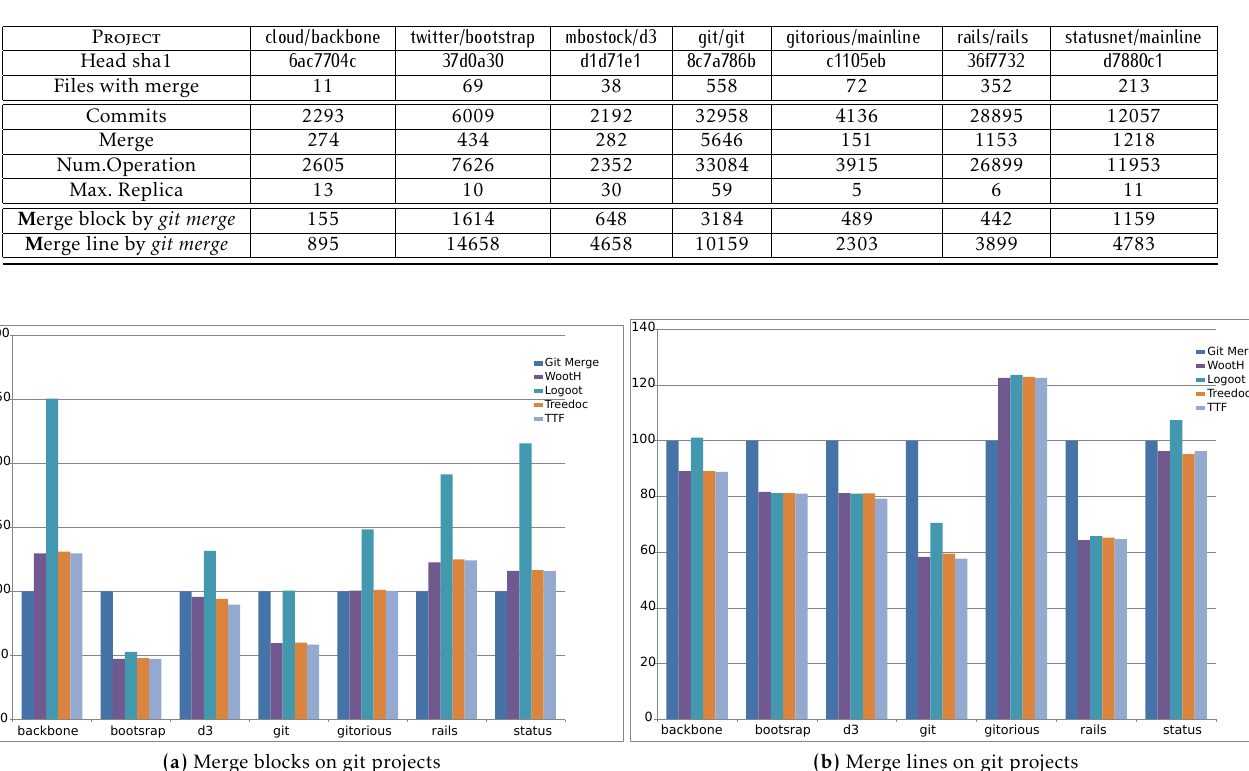
Figure 9. Merge blocks and merge